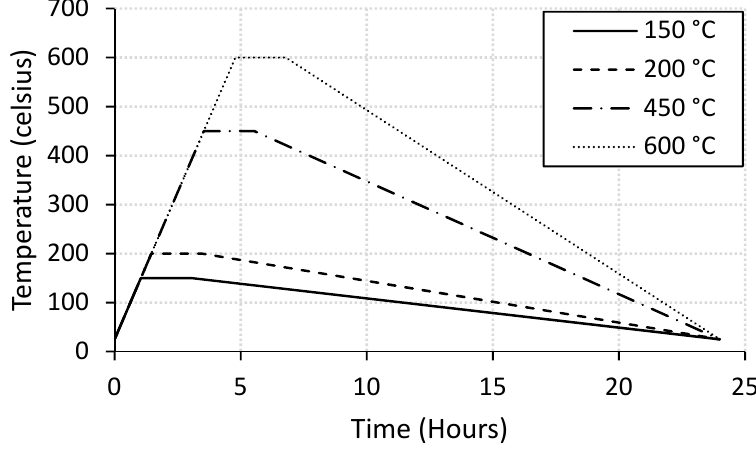
Figure 1. Temperature–time profiles.